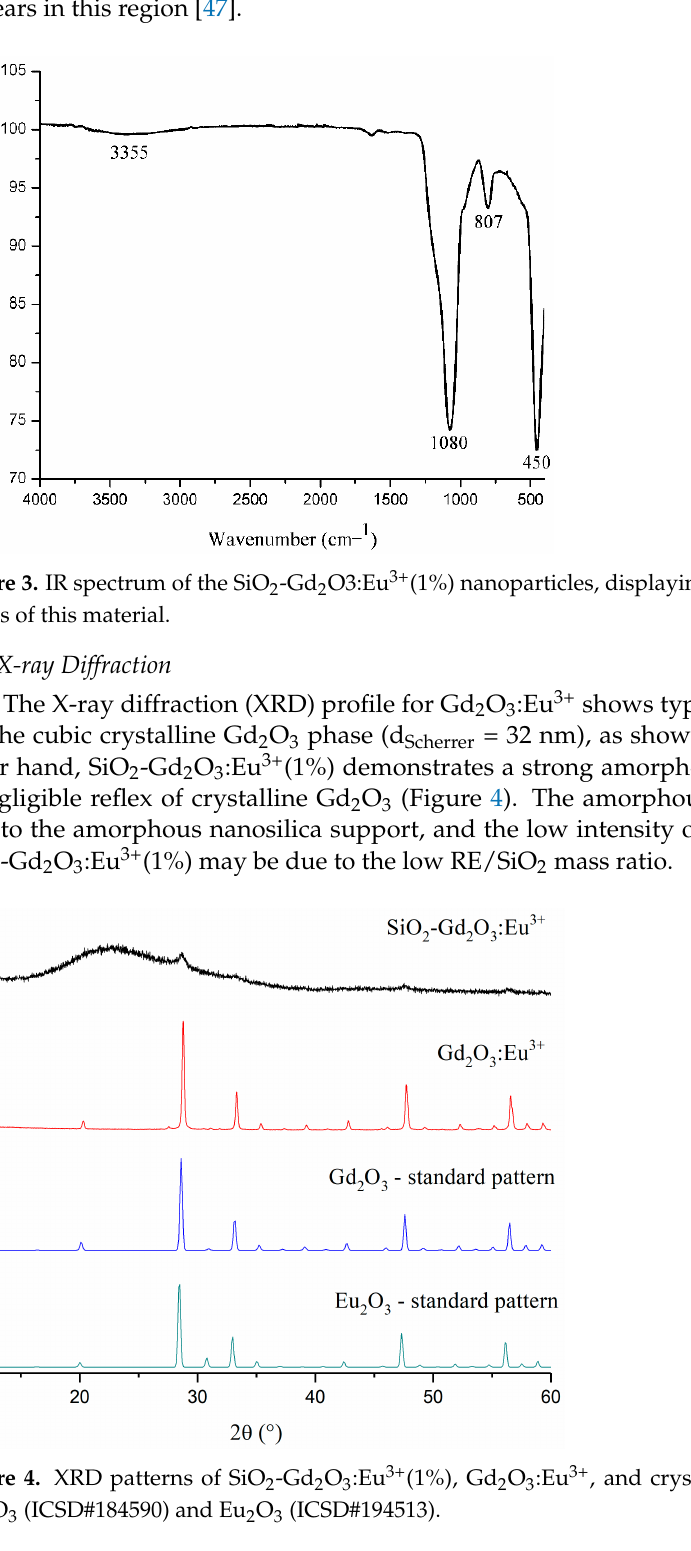
( b ) Figure 5. SEM image of Gd 2 O 3 :Eu 3+ nanoparticles at 10 4 times magnification ( a ) showing the aggregates of uniformly distributed nanoparticles and SEM image at 3 × 10 4 augmentation and ( b )